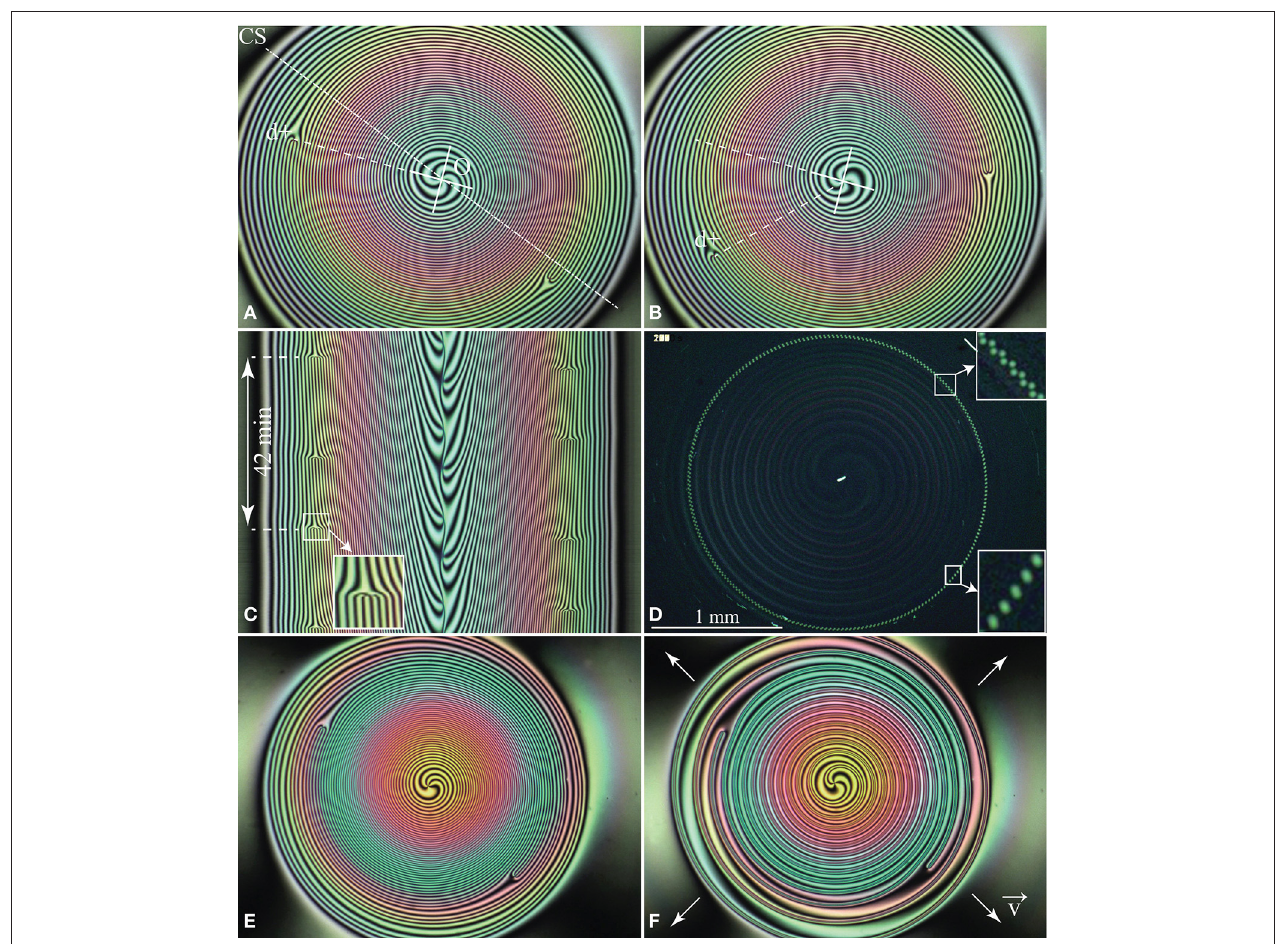
FIGURE 12 | Dynamics of the stable triplet configuration of dowsons. (A,B) Two pictures of the wound up dowser texture taken at an interval of 5 min. In this interval, the dowson d − in the center rotated by π /2, while the dowson d + on their orbits made only 1/8th of the whole turn. (C) Spatio-temporal cross section taken along the dashed line CS defined in (A) . The inset shows that the orbiting dowson d + acts as a phase sink: after each crossing of the line CS by one of orbiting dowsons d + , four isogyres are suppressed. Simultaneously four new isogyres are emitted by the dowson d − rotating in the center O. (D) Successive positions of the two dowsons d + recorded at intervals of 10 s during one period of their orbital motions. The two inset show that velocities of the two dowsons d + are the same. (E,F) To check that the two dowsons d + are isophasic, a divergent Poiseuille flow was applied to the wound up dowser field shown in (E) .